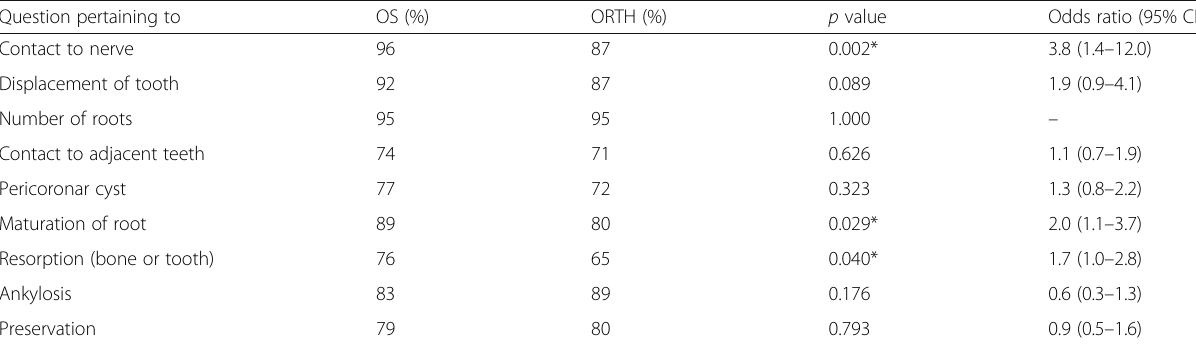
Table 3 Accuracy of the diagnostic answers given, according to specialisation: residents in oral surgery versus residents in orthodontics